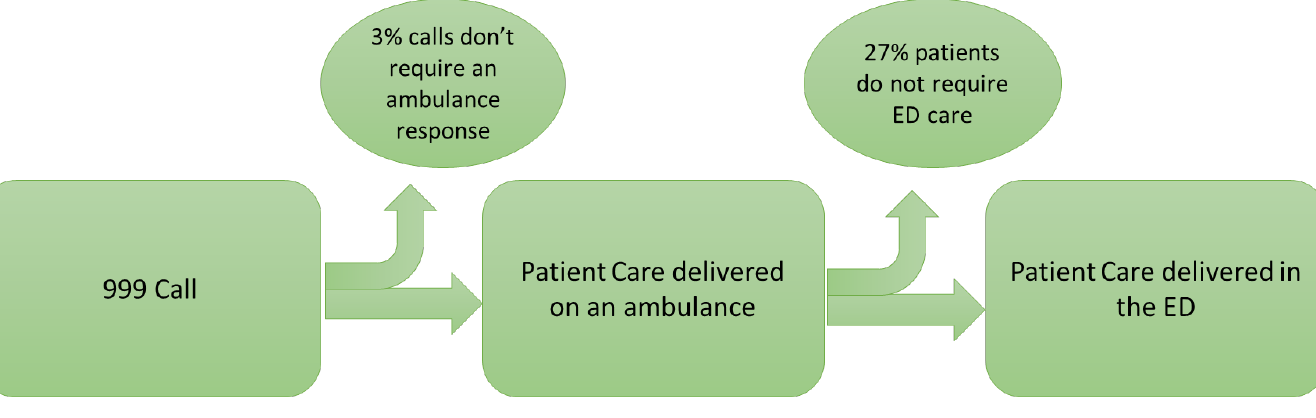
Figure 1: The flow of patients through the ambulance service to the Emergency Department